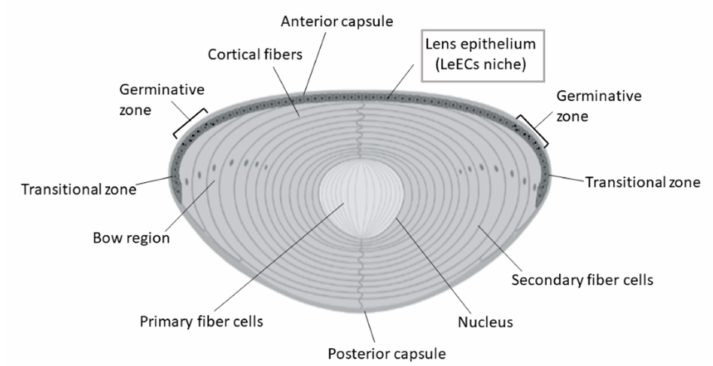
Figure 8. Structure of the human crystalline lens. Adapted from Sharma et al. [186]. The vertebrate lens contains high levels of structural proteins known as